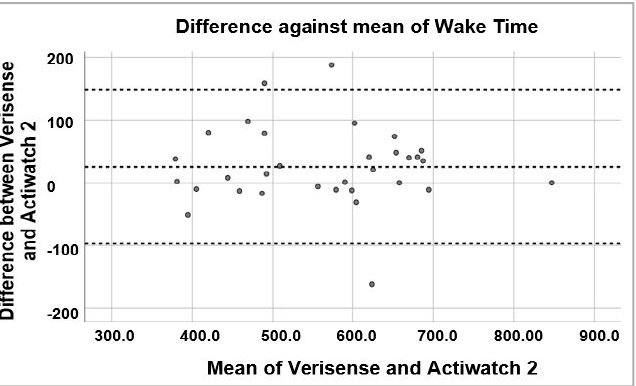
Figure 7. Bland–Altman plot of wake times estimated by Verisense as compared to Actiwatch 2.